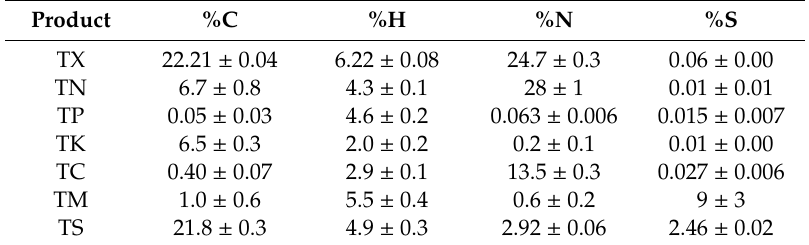
Table 1. Percentages of carbon (C), hydrogen (H), nitrogen (N) and sulfur (S) of the MCT ® fertilizers tested. Data were represented as the mean ± standard deviation ( n = 4).